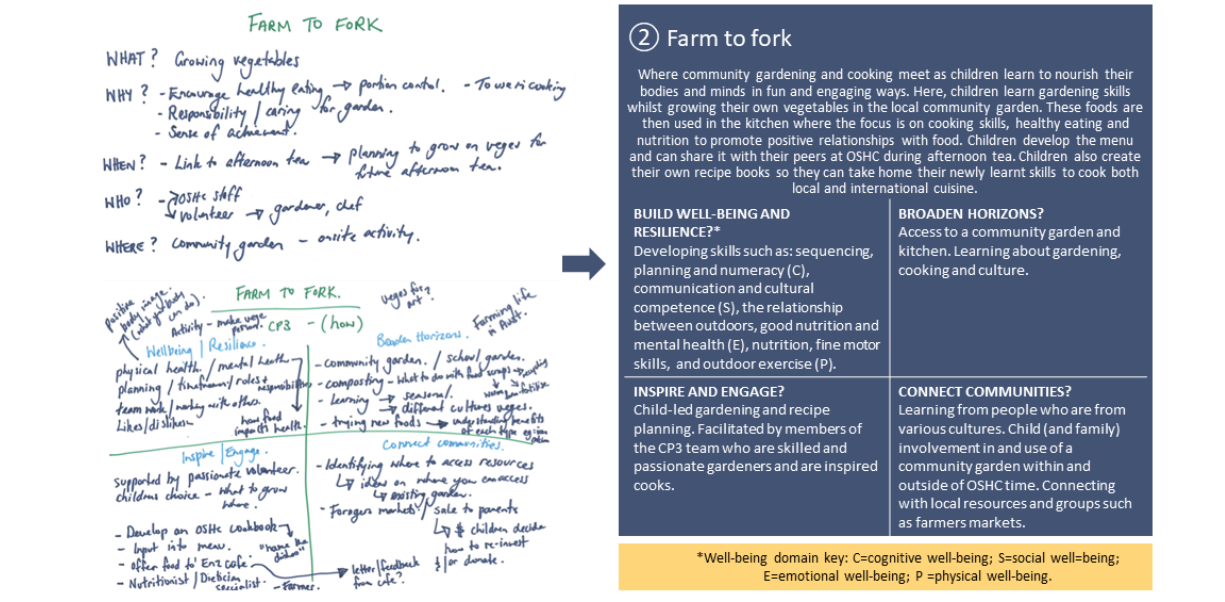
Figure 5. Example excerpts from connect, promote, and protect program enhanced activity planning.